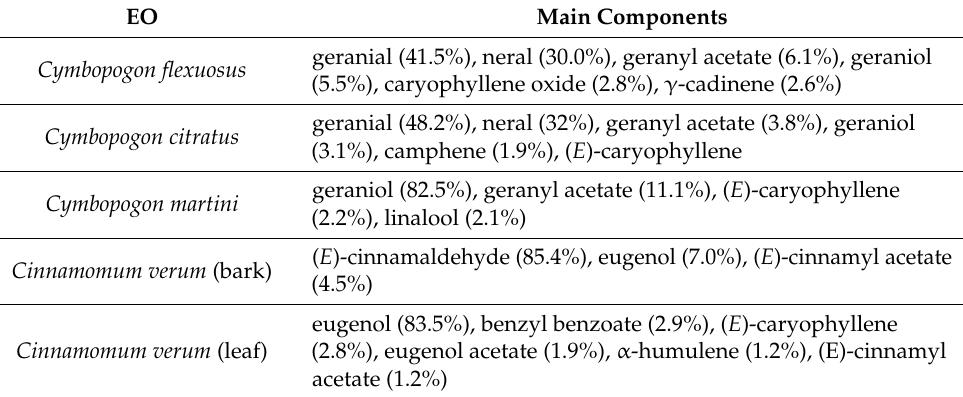
Table 1. The main components present in the tested essential oils (Eos) at relative percentages higher than one percent.